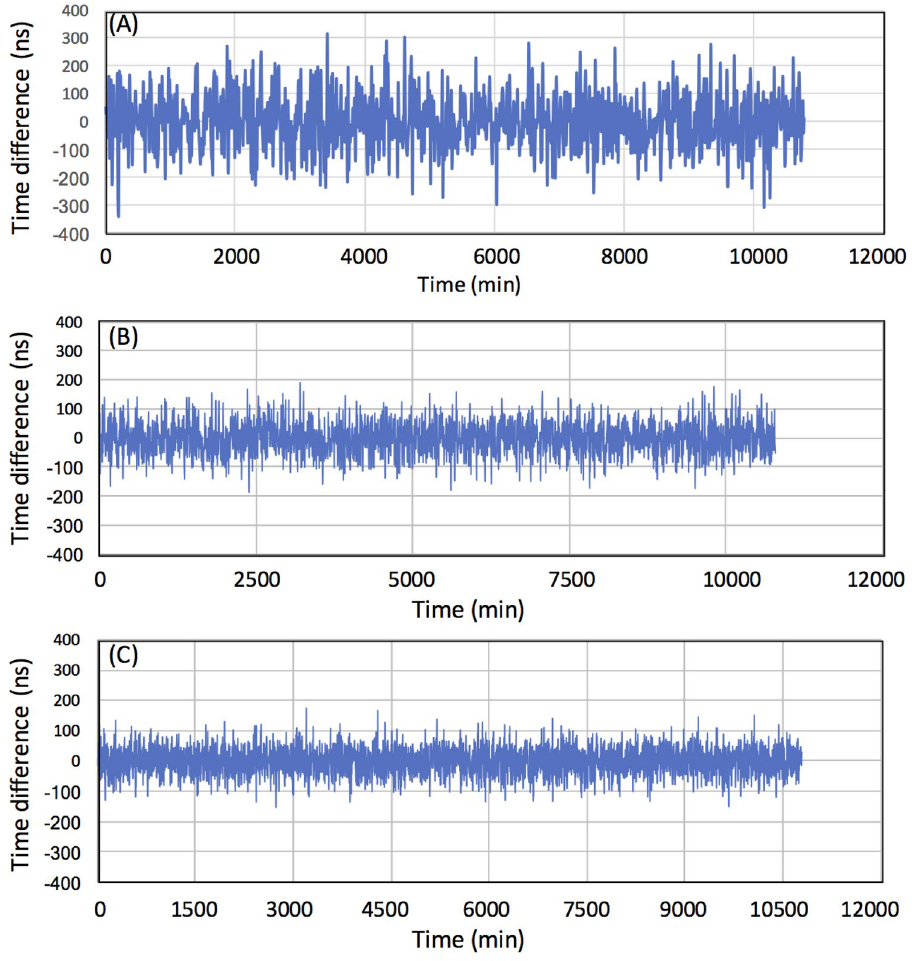
Figure 5. Time profiles after 1 week of CTS operation. The results with hypothetical detector arrays of areal coverages 5 × 10 −5 ( A ), 1 × 10 −4 ( B ), and 2 × 10 −4 ( C ) are